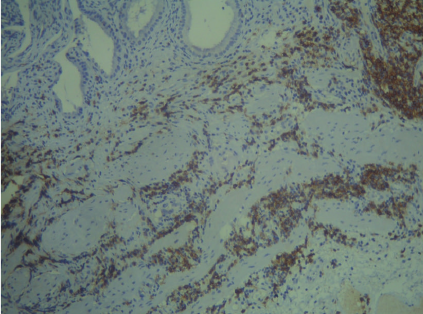
Figure 1: Hematoxylin-eosin stain ( ×400 ) showing small lympho- cytes with round nuclei, small nucleoli, and scant cytoplasm.